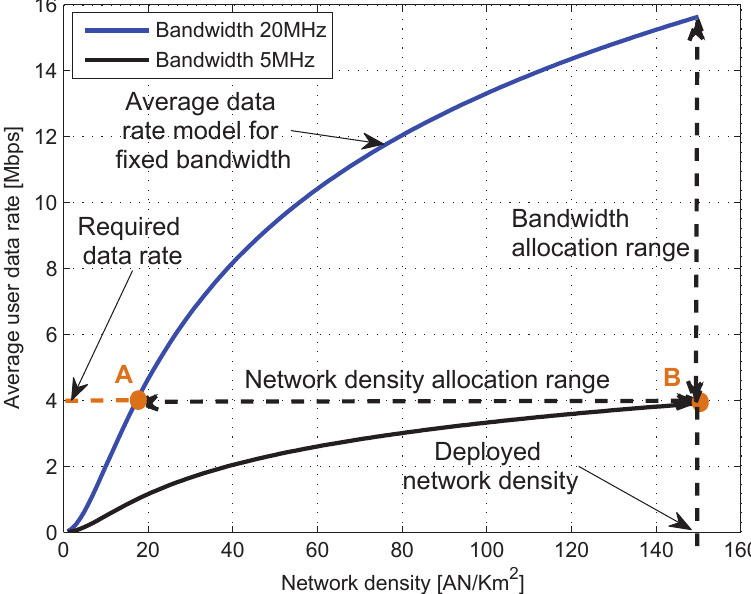
Figure 2. Illustration of the average data date model of Section 2.2 as function of the network density (horizontal axis) for different bandwidths (20 MHz in blue, 5 MHz in black). The figure further illustrates the resource allocation tradeoff between network density (AN/km 2 ) and frequency bandwidth to provide a requested average user traffic